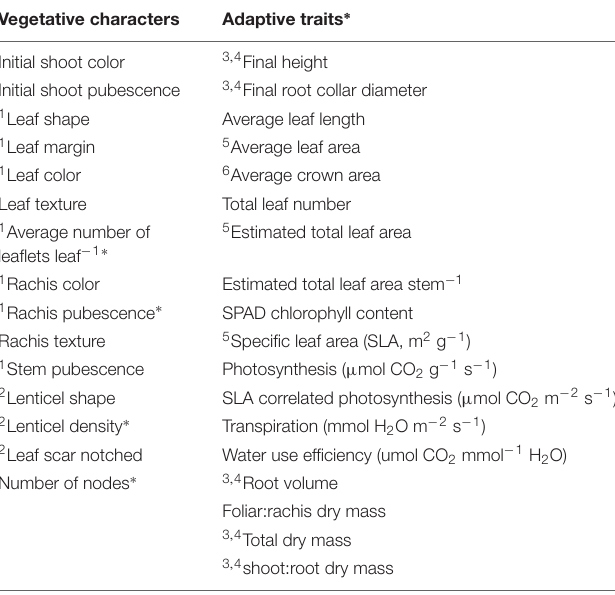
TABLE 1 | Vegetative characters and functional adaptive traits with transformations used in